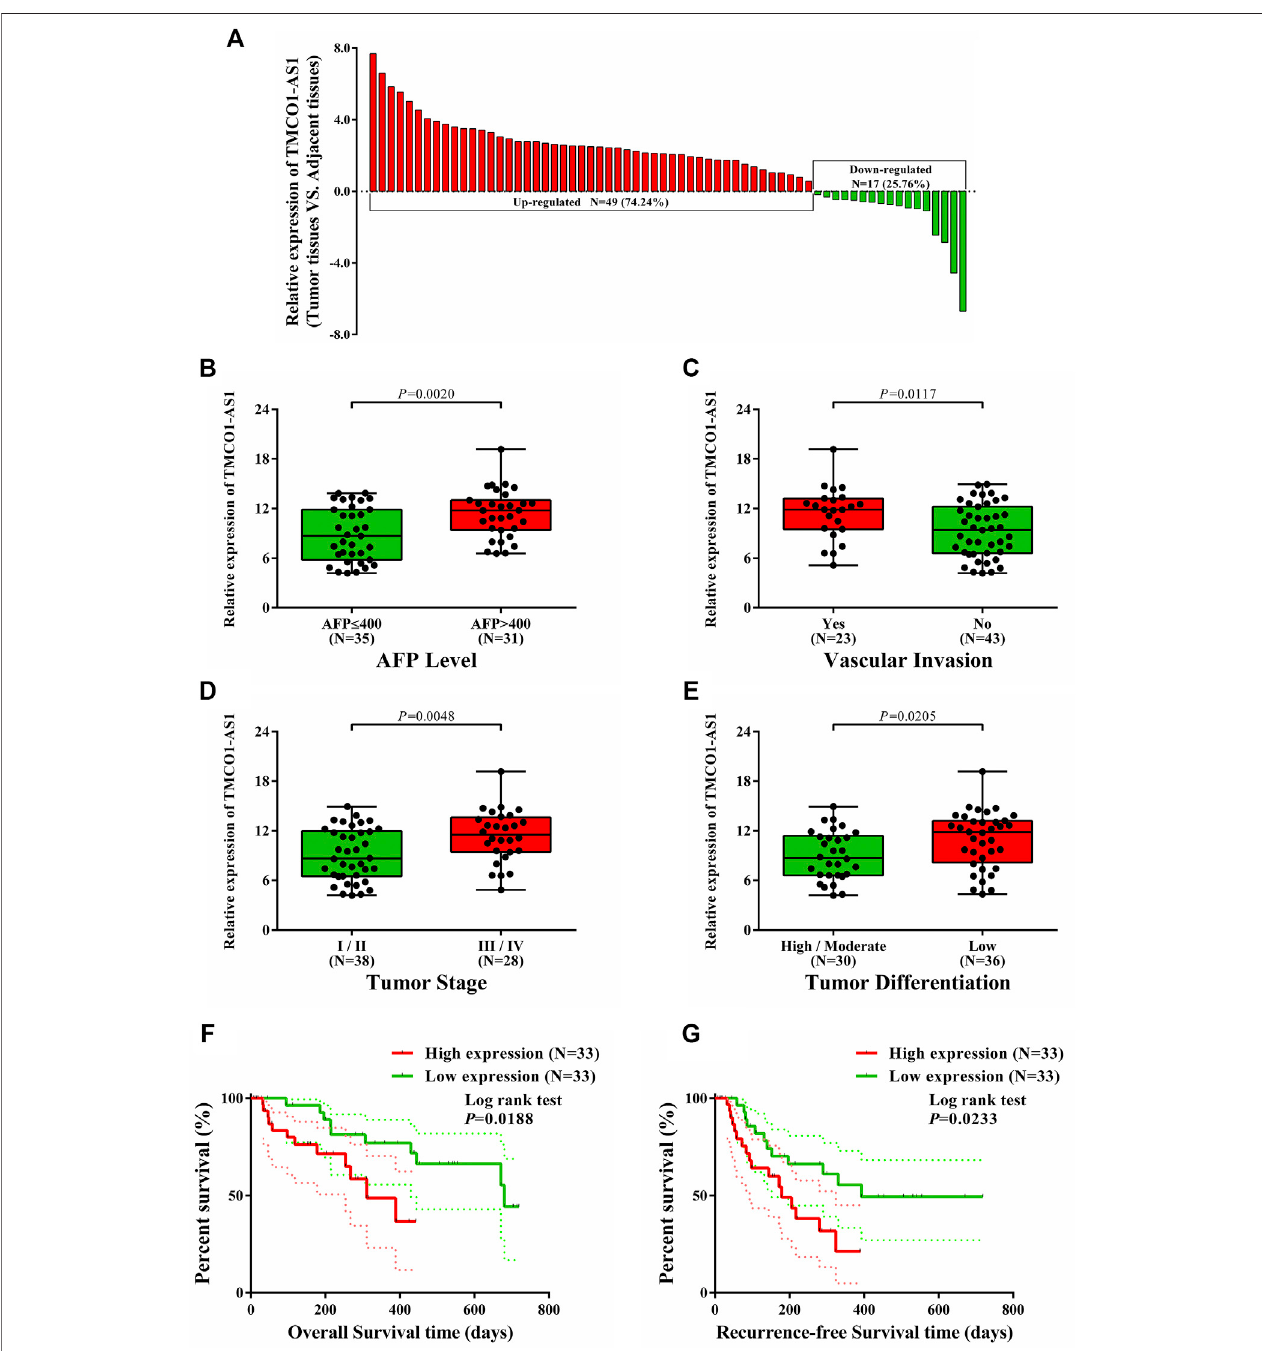
FIGURE4| RelationsbetweenTMCO1-AS1expressionandclinicalcharacteristicsofHCCpatientstreatedatourcenter. (A) RelativeexpressionofTMCO1-AS1in 66 HCC and adjacent normal tissues. (B) TMCO1-AS1 expression in patients with high and low serum AFP levels. (C) TMCO1-AS1 expression in patients with and without vascular invasion. (D) TMCO1-AS1 expression in patients with different tumor stages. (E) TMCO1-AS1 expression in patients with different degrees of tumor differentiation. (F) Kaplan-MeiercurvesforOSofpatientswithhighandlowTMCO1-AS1expression. (G) Kaplan-MeiercurvesforRFSofpatientswithhighandlow TMCO1-AS1